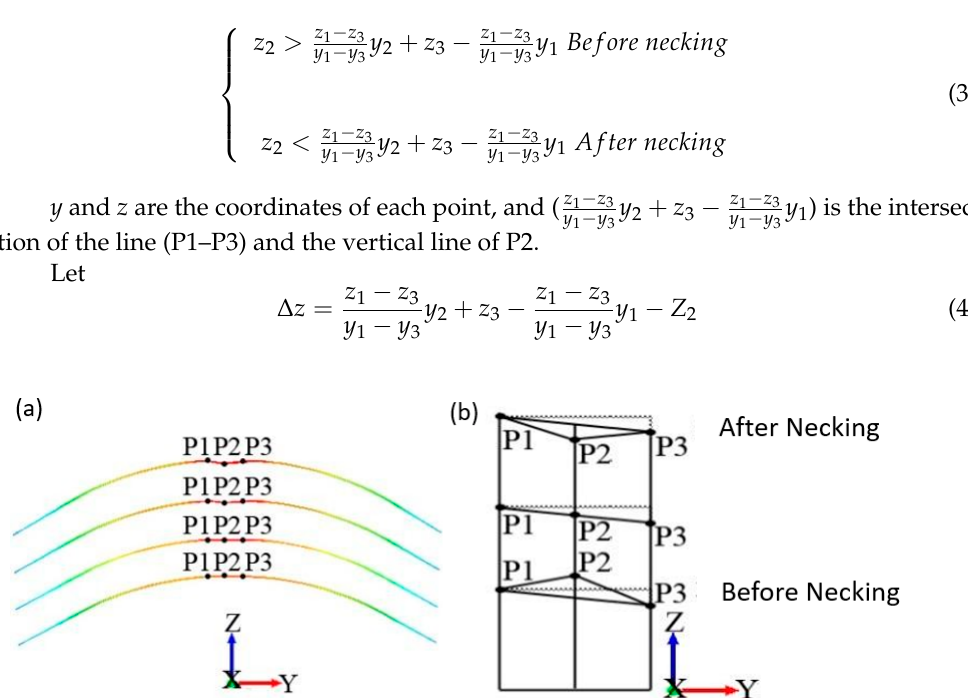
Figure 10. Variation of adjacent points in the high strain zone: ( a ) Cloud image, ( b ) Geometric calculation diagram.